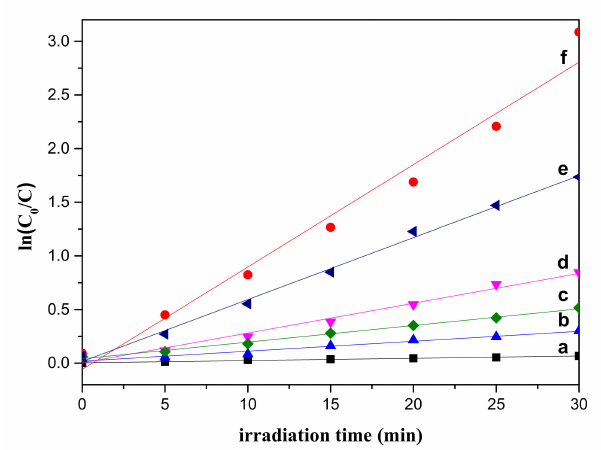
Figure 7. Linear fit between ln(C 0 /C) and time of photocatalysis degradation of MB solution by using different catalysts: ( a ) without catalyst; ( b ) 0.5 h; ( c ) 2 h; ( d ) 6 h; ( e ) 10 h after calcination; ( f ) 10